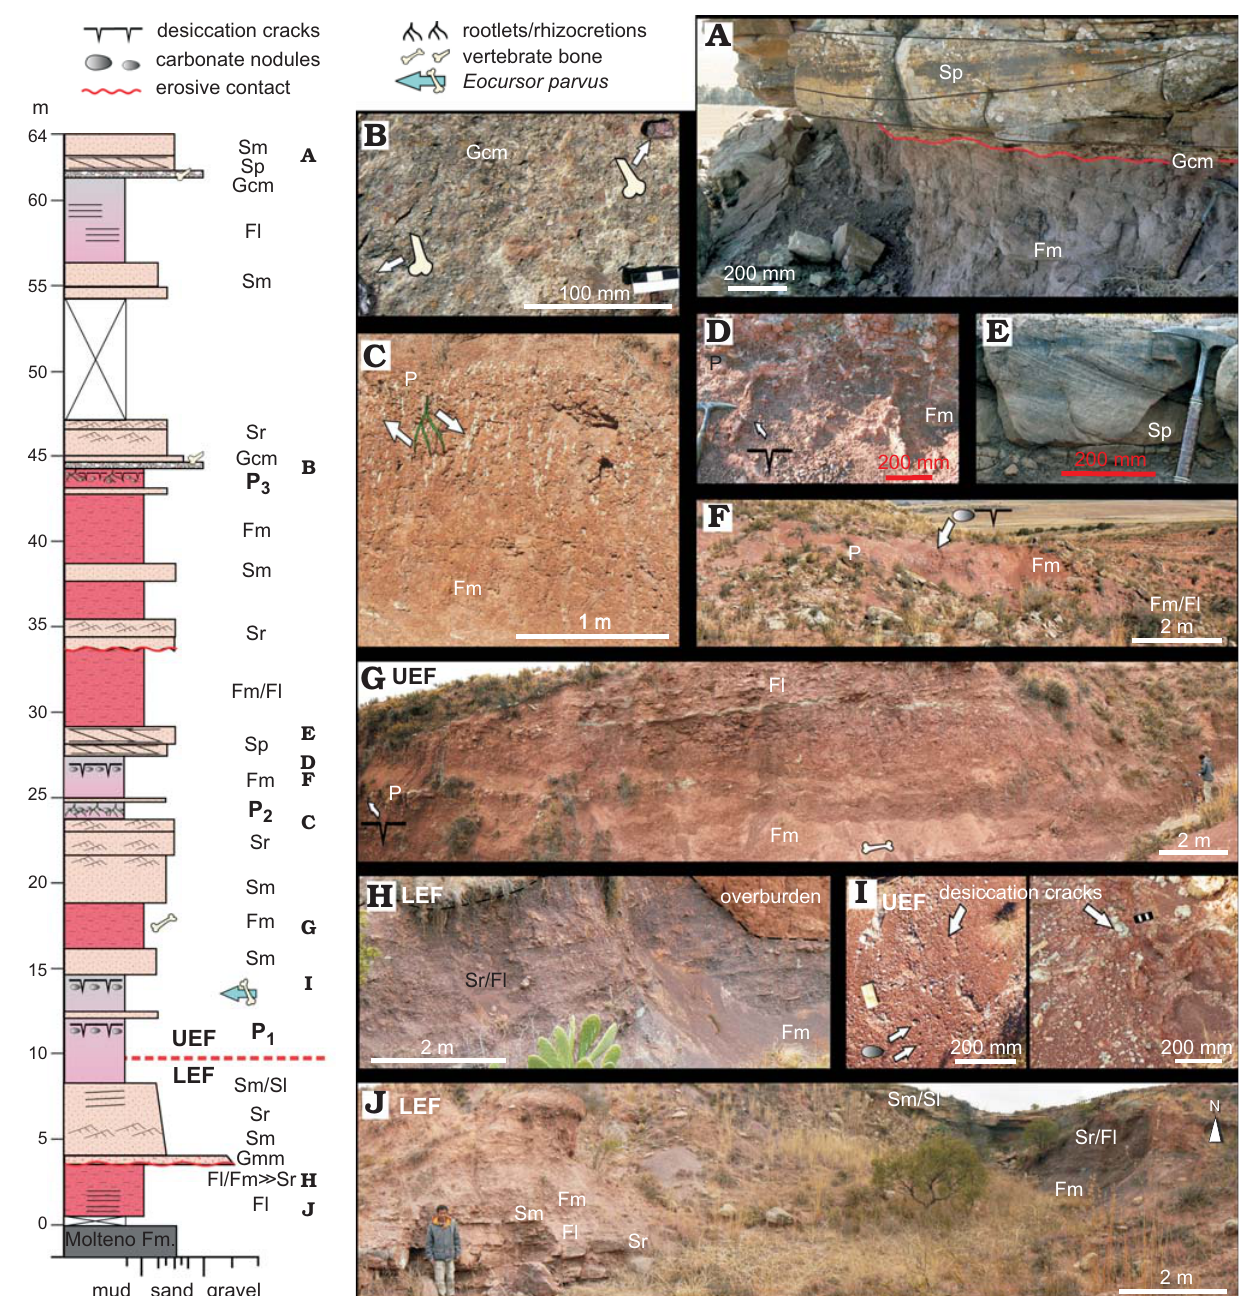
Fig. 5. Lithostratigraphic details of the erosional gully (donga) located on Damplaats Farm. Abbreviations: Fl, horizontal laminated mudstone; Fm, mas- sive mudstone; Gcm, clast-supported conglomerate; Gmm, matrix-supported conglomerate; P, paleosol; Sl, low-angle cross-bedded sandstone; Sm, mas- sive or faintly laminated sandstone; Sp, cross-bedded sandstone; Sr, ripple cross-laminated